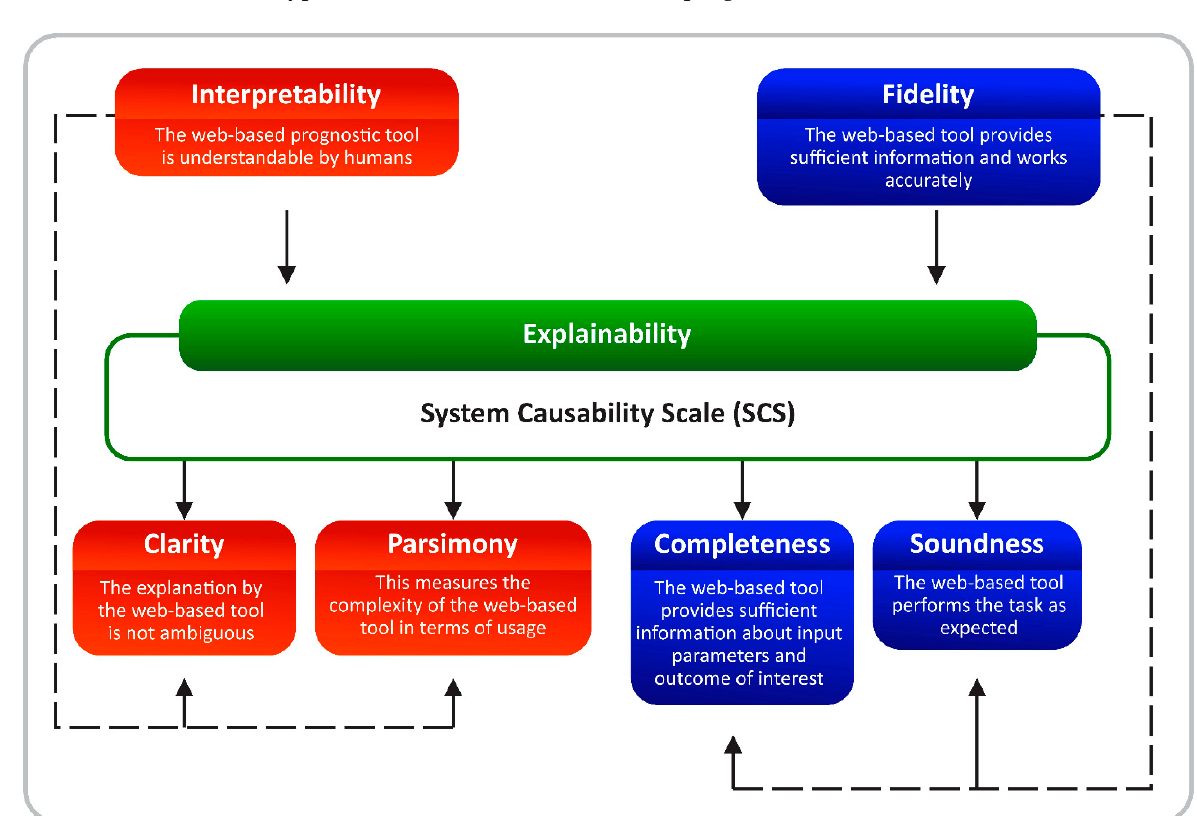
Figure 6. The essential components of explainability.